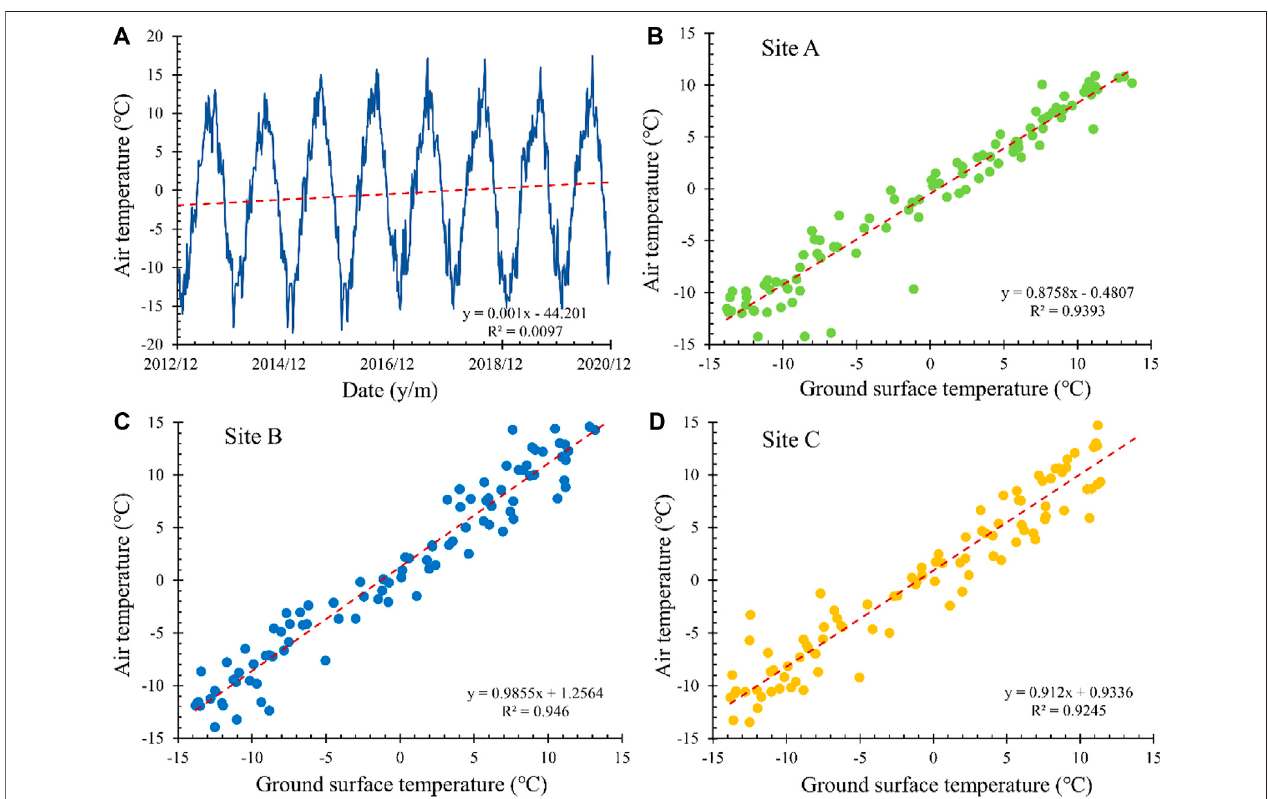
FIGURE 2 | Daily mean air temperature at the study site (A) , and mean monthly ground surface temperature (0.05 m depth) vs. mean monthly air temperature during the period from December 2012 toNovember 2020at (B) Site A, (C) SiteB, and (D) Site C.Thelinearregressioncoef fi cients and coef fi cient ofdetermination ( R 2 ) are also shown in this fi